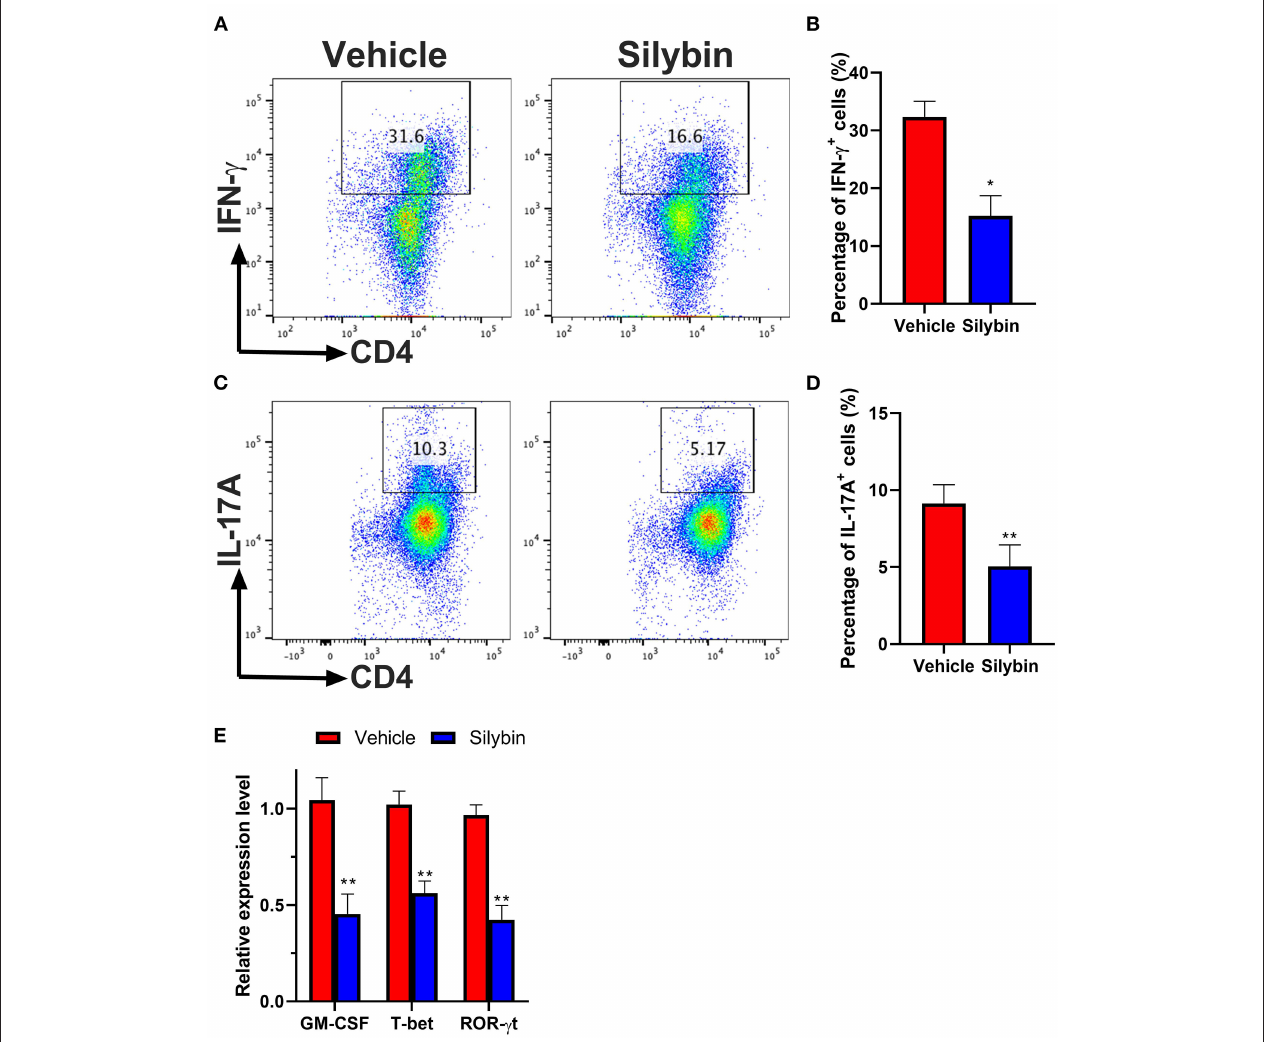
FIGURE 7 | Silybin-treated bone marrow-derived dendritic cells (BM-DCs) induce Th1 and Th17 CD4 + T-cell polarization in vitro . (A,C) Intracellular staining for IFN- γ and IL-17A of naïve CD4 + T cells after 3 days of co-culture with lipopolysaccharide (LPS)-activated BM-DCs. (B,D) Analysis of IFN- γ - and IL-17A-positive CD4 + T cells by division number as assessed by intracellular staining. (E) RNA extraction of from the vehicle- or silybin-treated T cells and RT-PCR was performed to determine the mRNA expression level of granulocyte/macrophage colony-stimulating factor (GM-CSF), T-bet, and ROR- γ t. Statistical data are expressed as mean ± SD of three independent experiments. * p < 0.05 and ** p < 0.01 by paired t